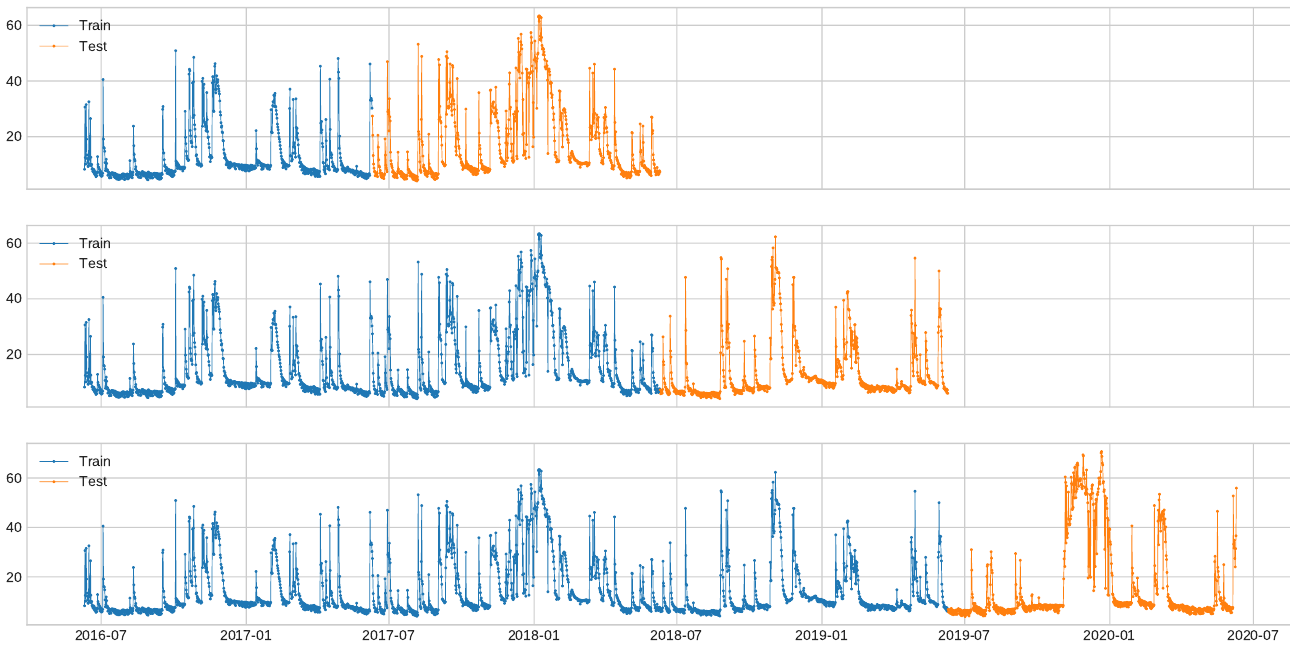
Figure 4. Example of the chosen procedure to generate training/test splits on one of the 12 signals that composes the facade